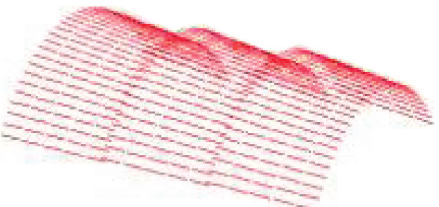
Figure 7: Beam unit of a small